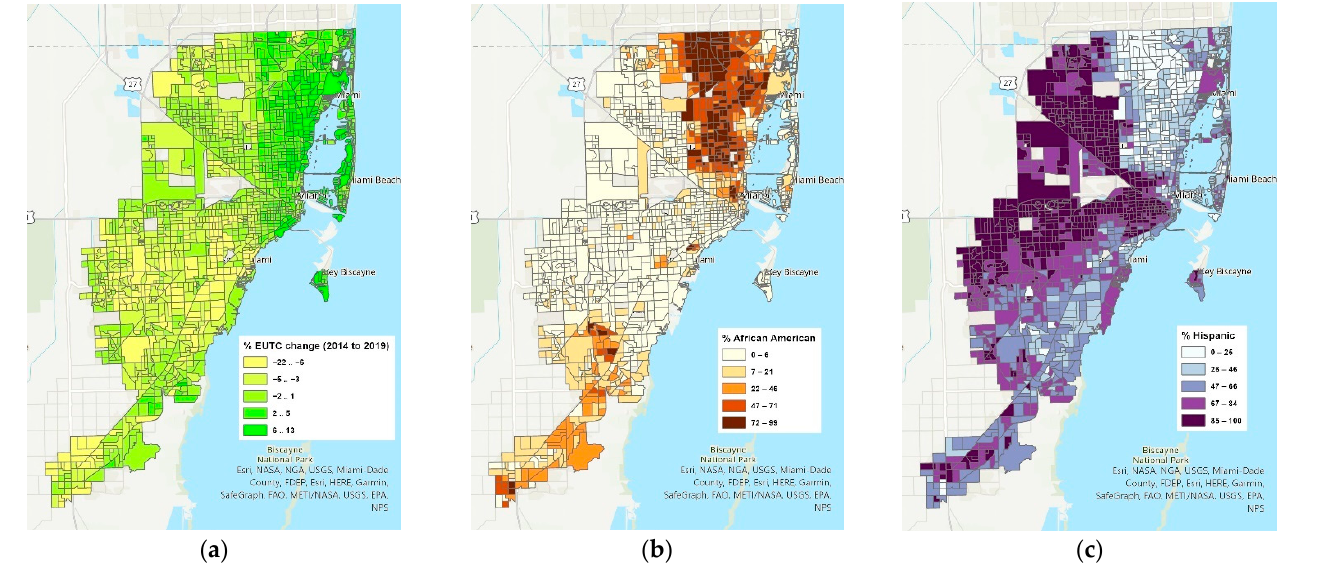
Figure 9. Tree canopy relative to race and ethnicity data at the block group level within the UDB of Miami-Dade County: ( a ) Change of % EUTC between 2014 and 2019, ( b ) % African American population in 2019, ( c ) % Hispanic population in 2019 (background map credits: Miami-Dade County, FDEP, Esri, HERE, Garmin, SafeGraph, FAO, METI/NASA, USGS, EPA, NPS).